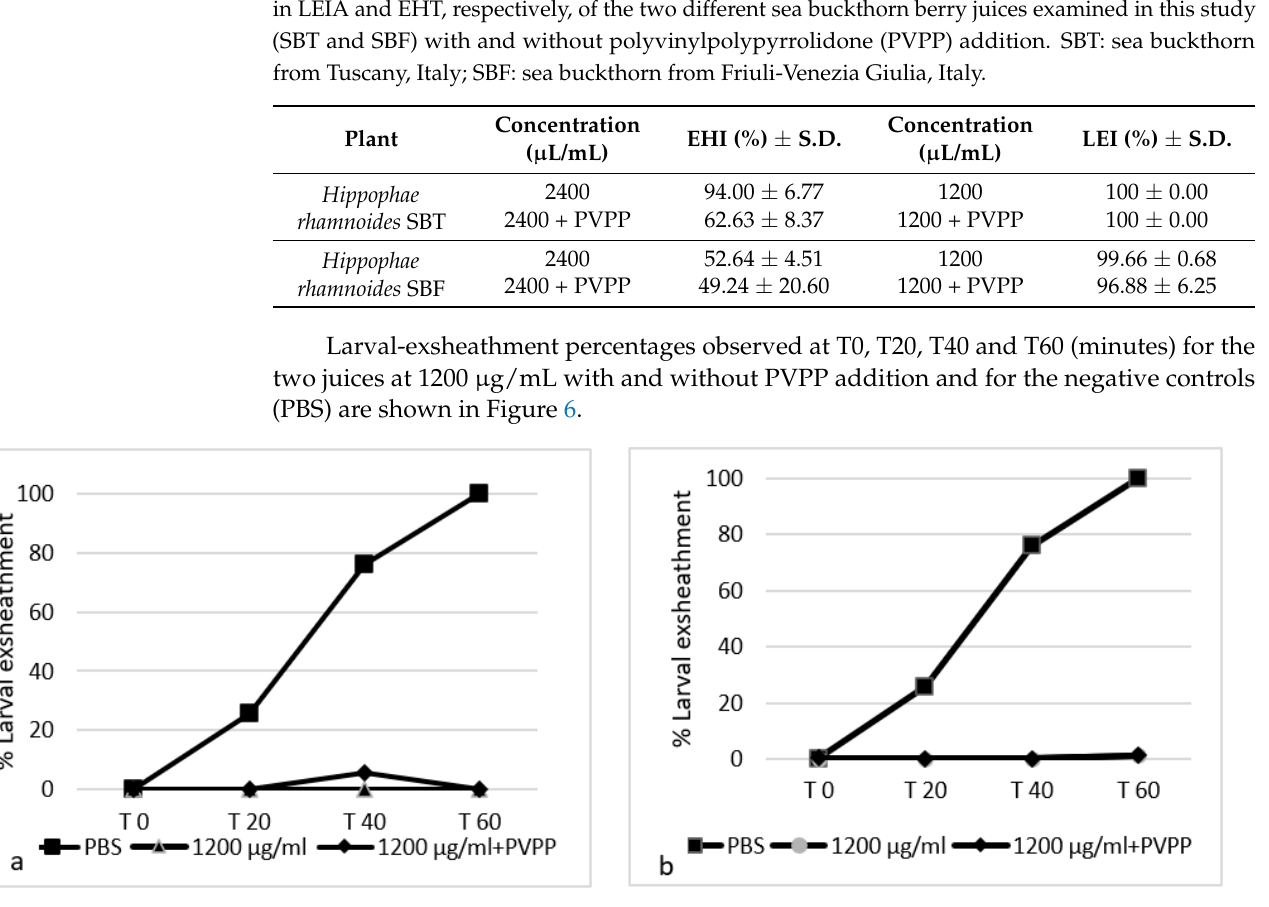
Figure 6. Graphical representation of the larval-exsheathment inhibition percentages caused after 0, 20, 40, and 60 min by the two sea buckthorn berry juices examined in this study (SBT and SBF) at a concentration of 1200 µg/mL, and with and without the addition of polyvinylpolypyrrolidone (PVPP). ( a ) Sea buckthorn from Tuscany, Italy (SBT); ( b ) sea buckthorn from Friuli-Venezia Giulia, Italy